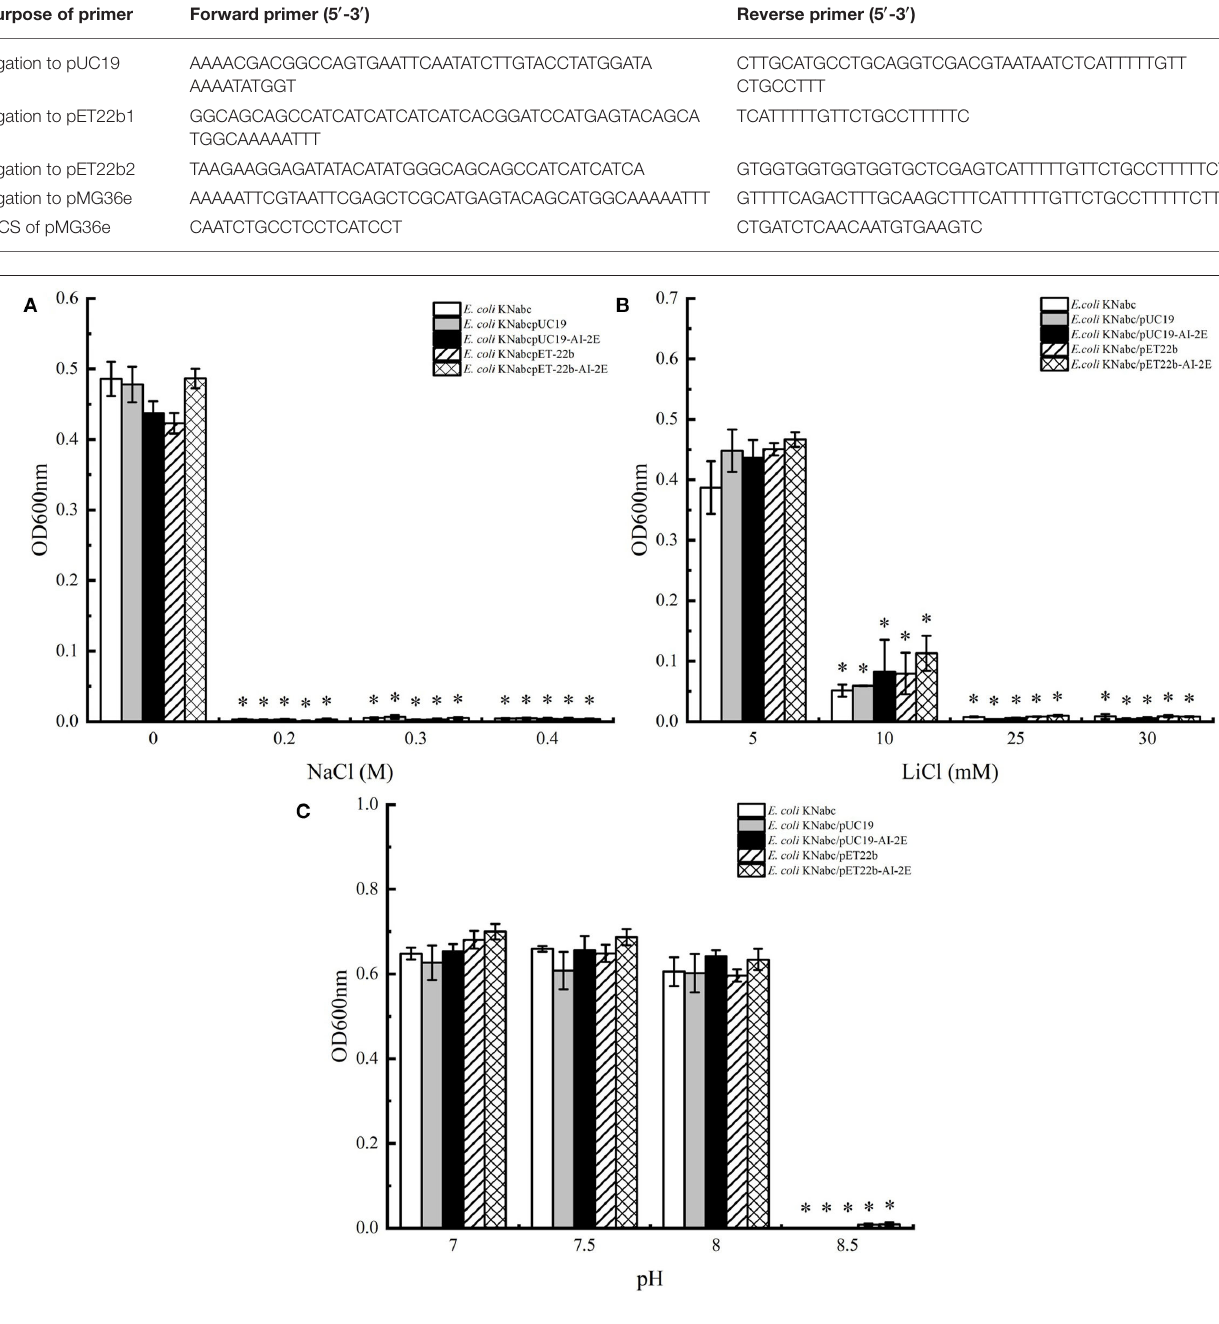
AI-2E protein of different LAB may have different